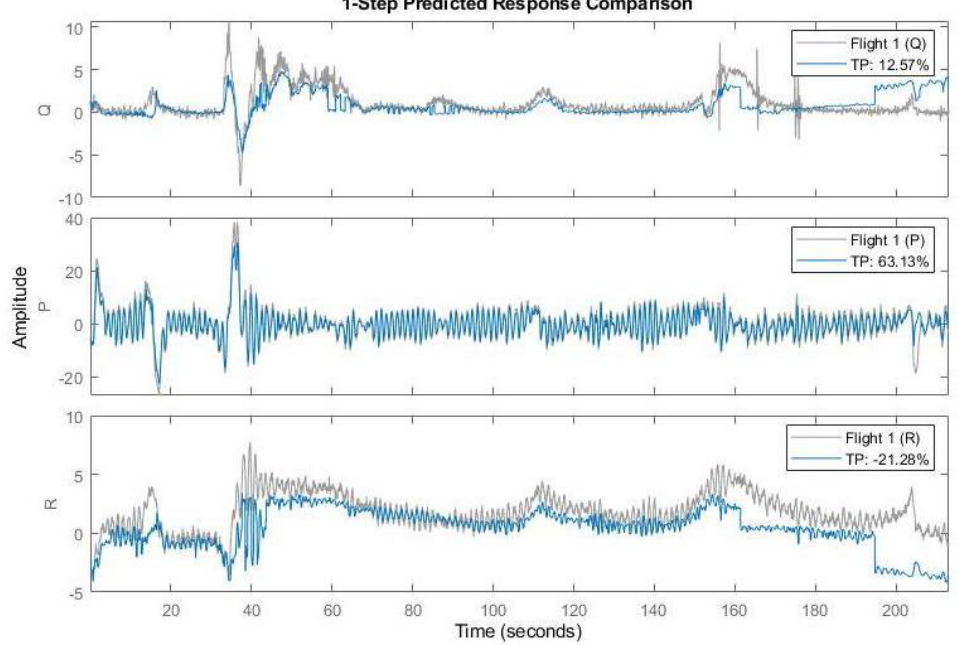
Figure 20. NLARX Tree Partition Model